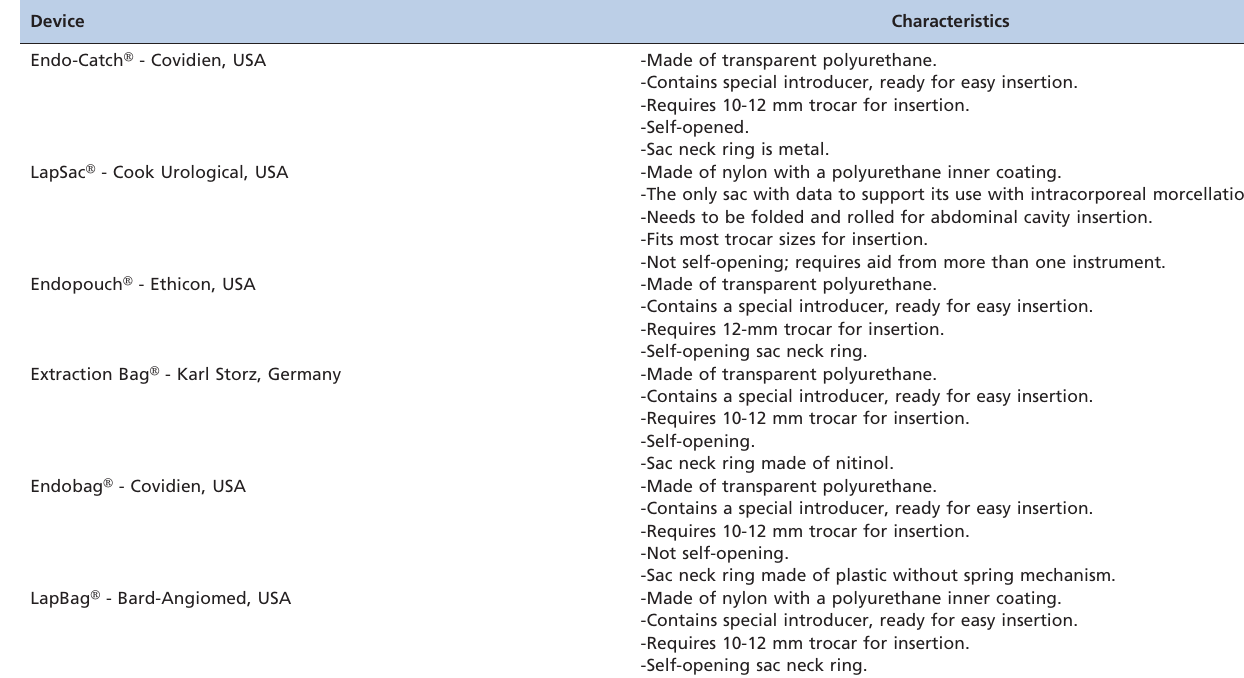
Table 1 - Laparoscopic specimen entrapment and retrieval